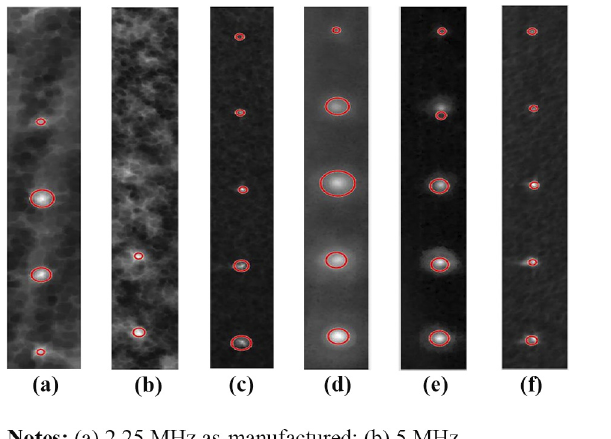
Figure 10. Sample L-41 side surface